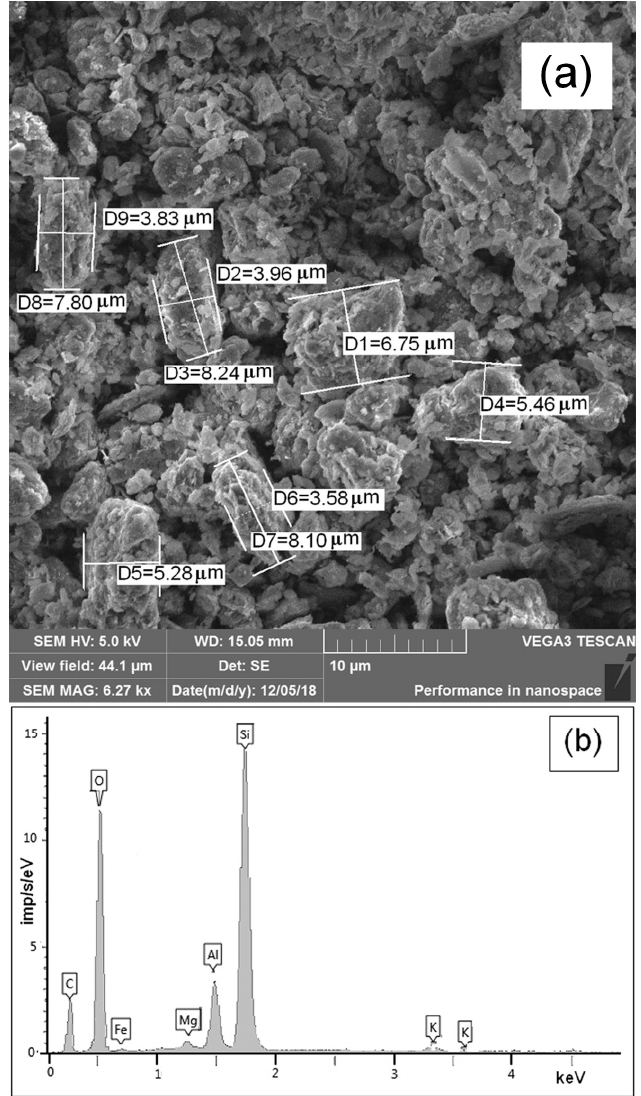
Figure 3. Scanning electron microscope (SEM) image ( a ) and energy-dispersive X-ray spectroscopy (EDX) analysis ( b ) of the MMT K10.